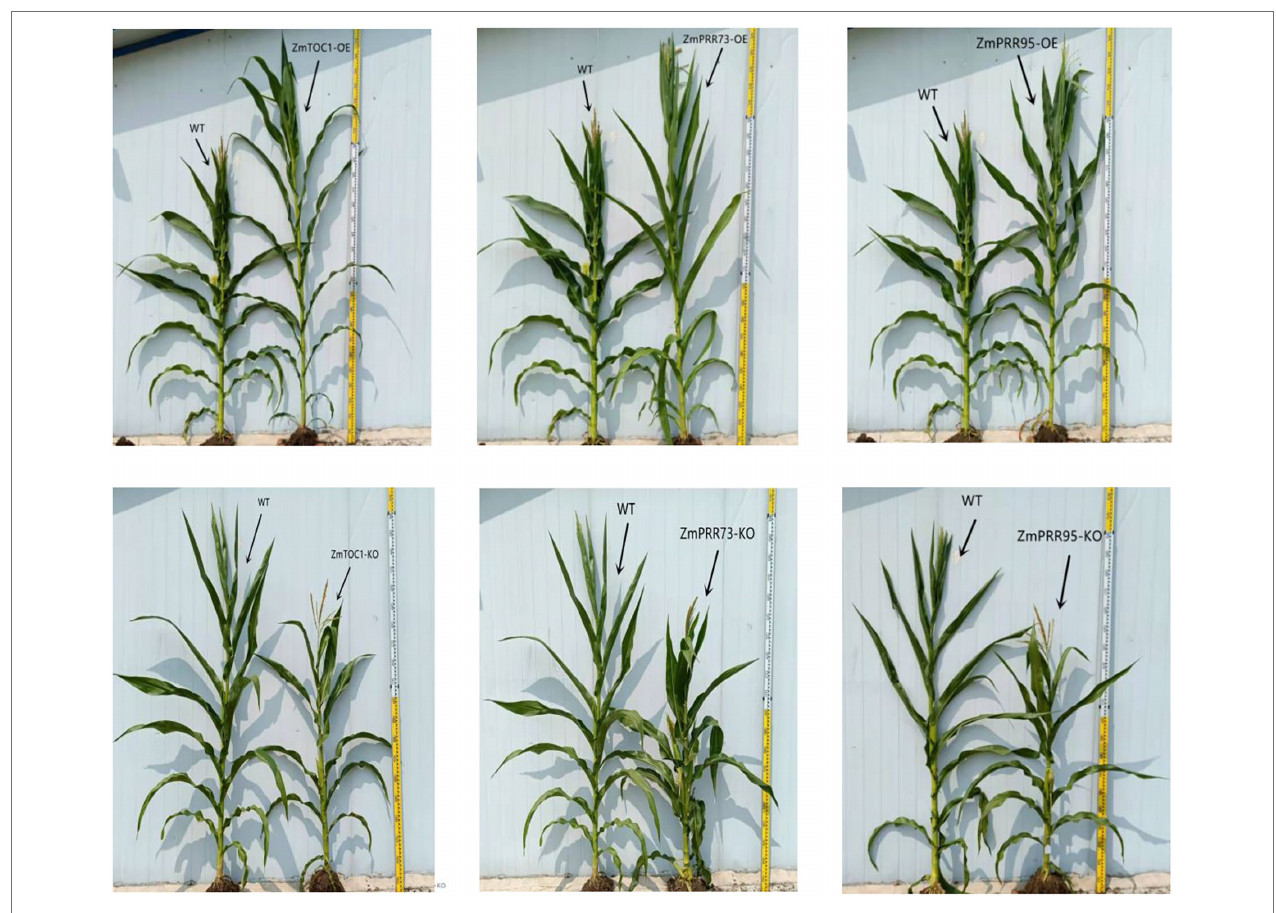
FIGURE 8 | Phenotypic differences between positive plants and